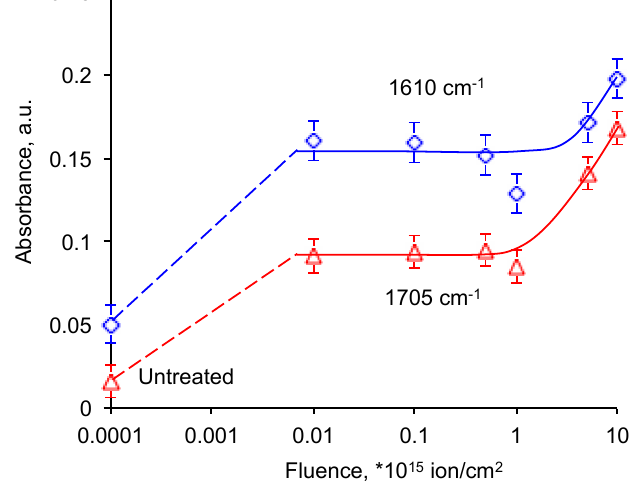
Figure A6. Normalized absorbance of ν (C=C) = 1610 cm − 1 line and ν (C=C) = 1610 cm − 1 line in FTIR ATR spectra of EPDM rubber with fluence of PIII without grid.